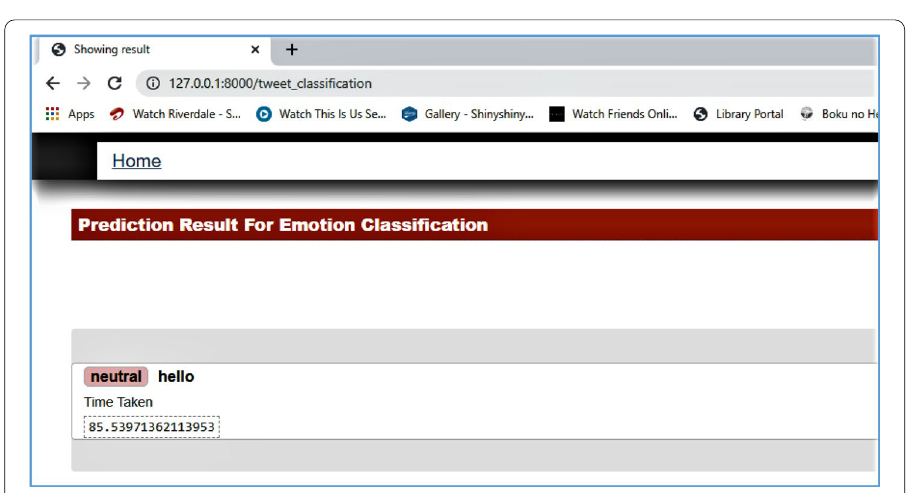
Fig. 23 Neutral Tweet with the time taken 85